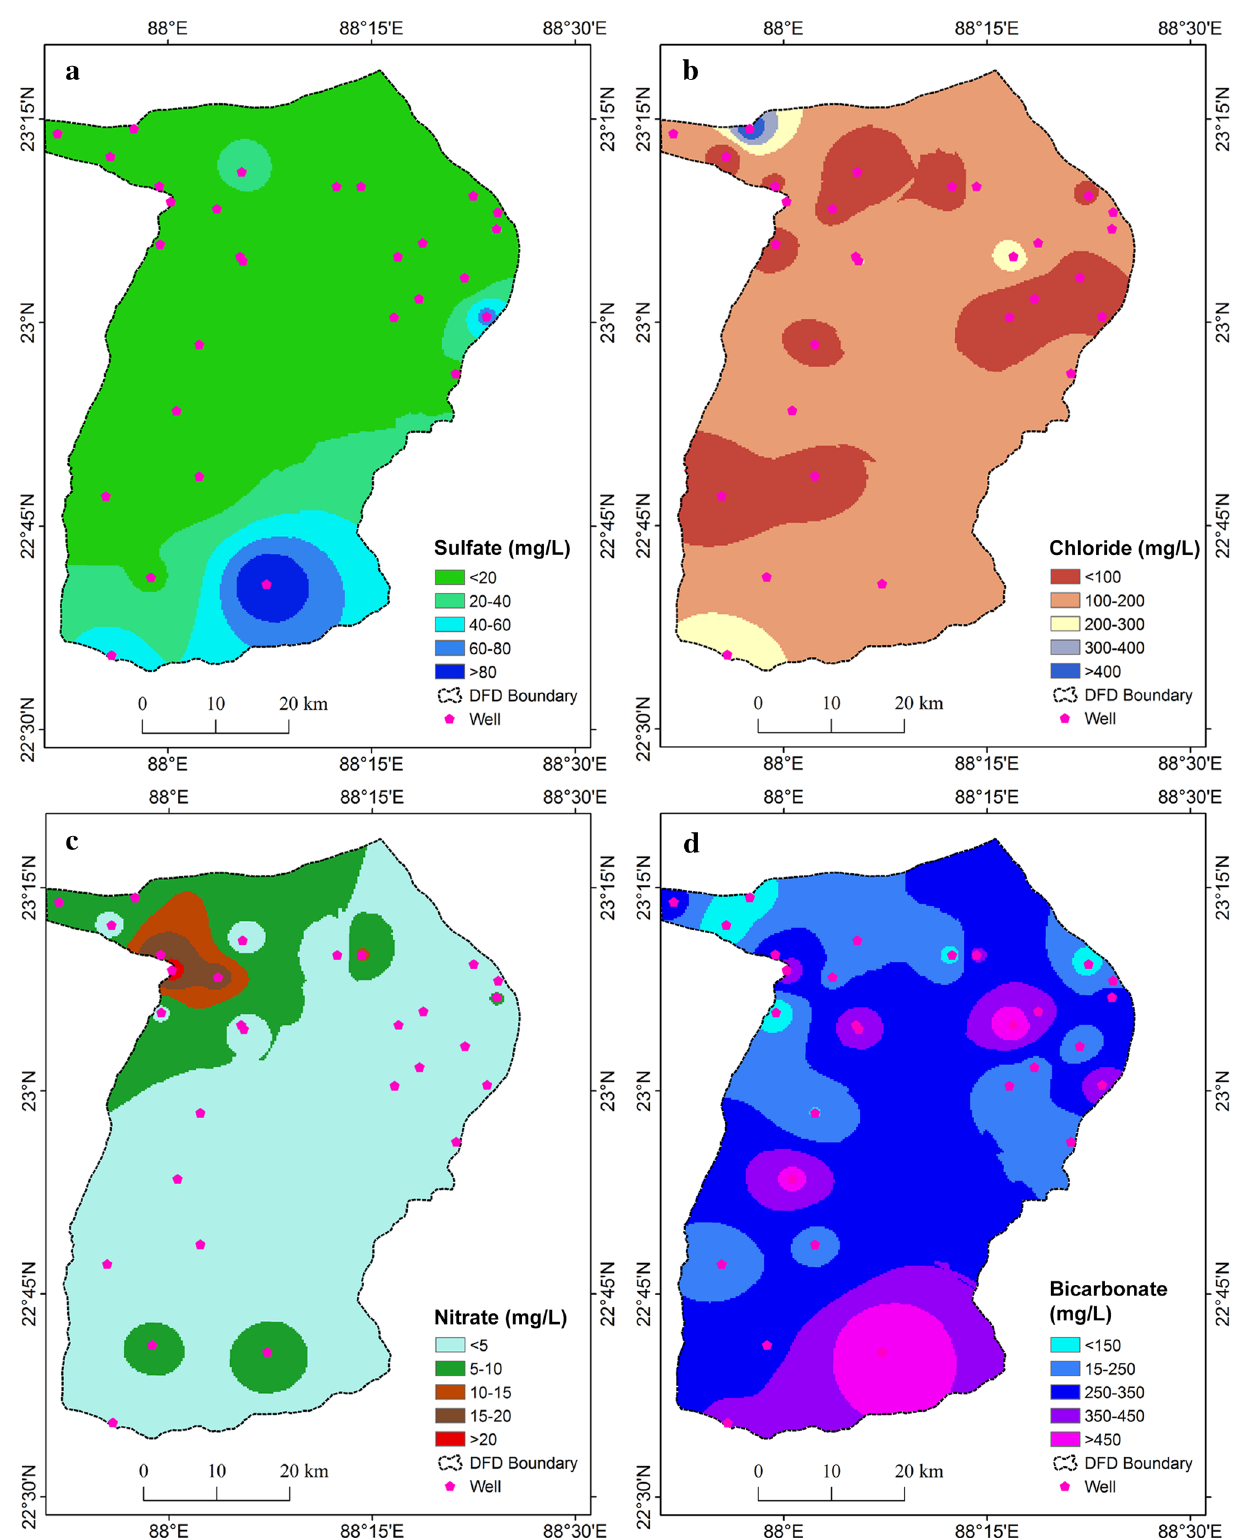
Fig. 7 Spatial distribution of major anions a sulfate, b chloride, c nitrate, and d